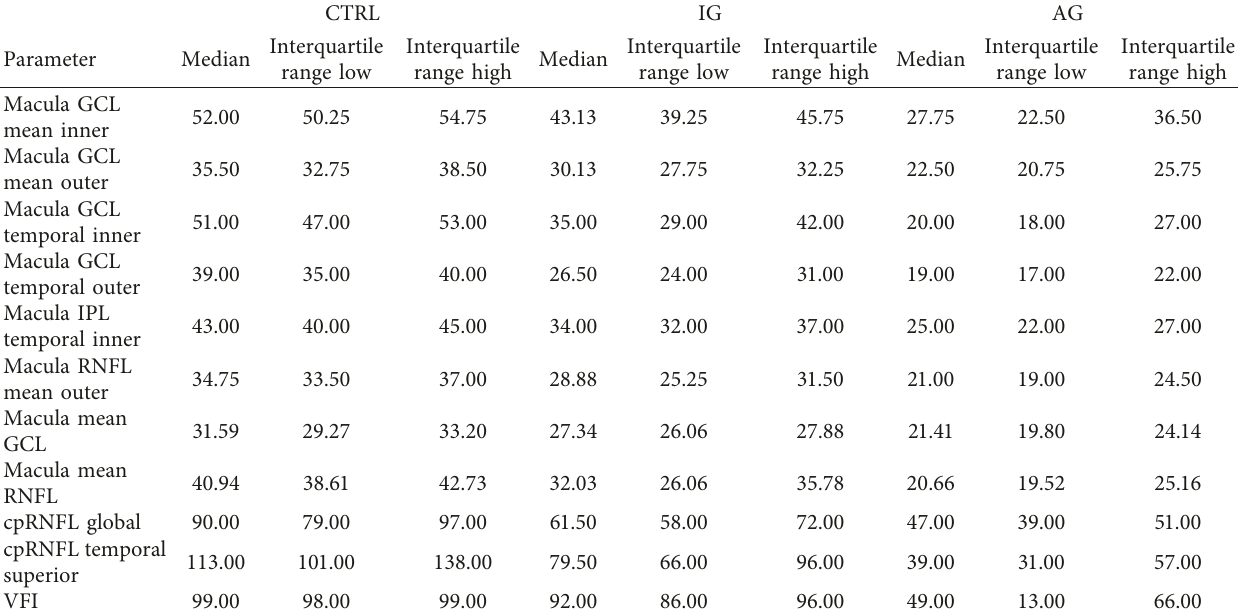
Table 2: Descriptive statistics of the parameters with the highest diagnostic ability in the CTRL vs. IG, CTRL vs. AG, and IG vs. AG comparisons.